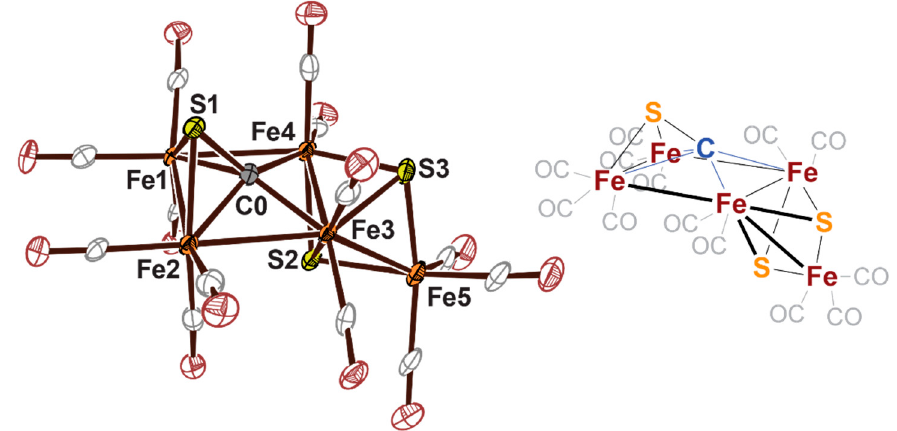
Figure 11. Thermal ellipsoid plots (50% probability) of [{Fe 4 ( κ 2 S– κ 4 C)(CO) 10 }( µ 3 -S) 2 Fe(CO) 3 ] ( 6 ). Orange = Fe, Gray = C, Yellow = S, Maroon = O. Image adapted with permission from Joseph, C., Cobb, C. R., Rose, M. J. Single-Step Insertion of Sulfides and Thiolate into Iron Carbide-Carbonyl Clusters: Unlocking the Synthetic Door to FeMoco Analogues. Angew. Chemie Int. Ed. 2020 , Accepted, not yet published . Copyright Wiley-VCH GmbH . Reproduced with permission.